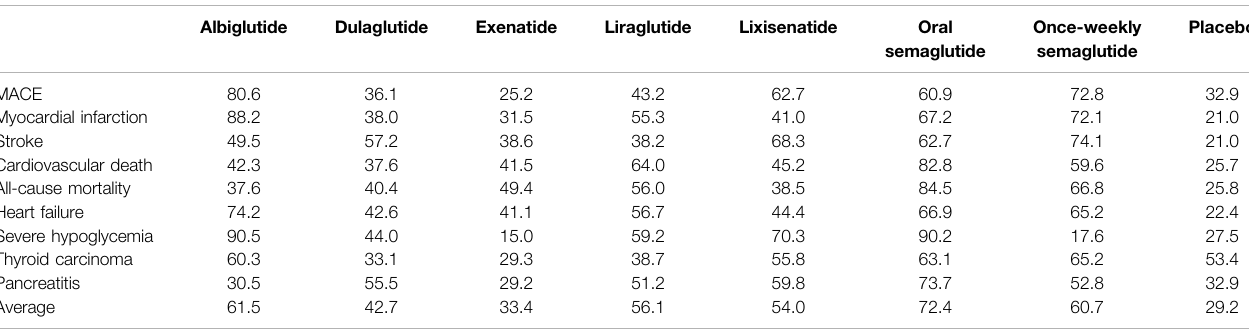
TABLE 3 | SUCRAs of treatments according to nine primary